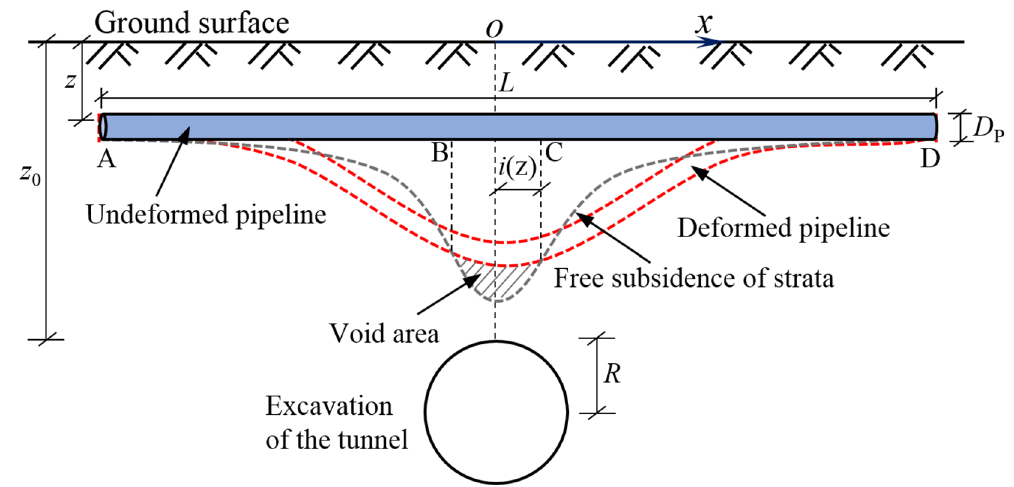
Figure 1. Mechanical model of pipe-soil interaction based on detachment